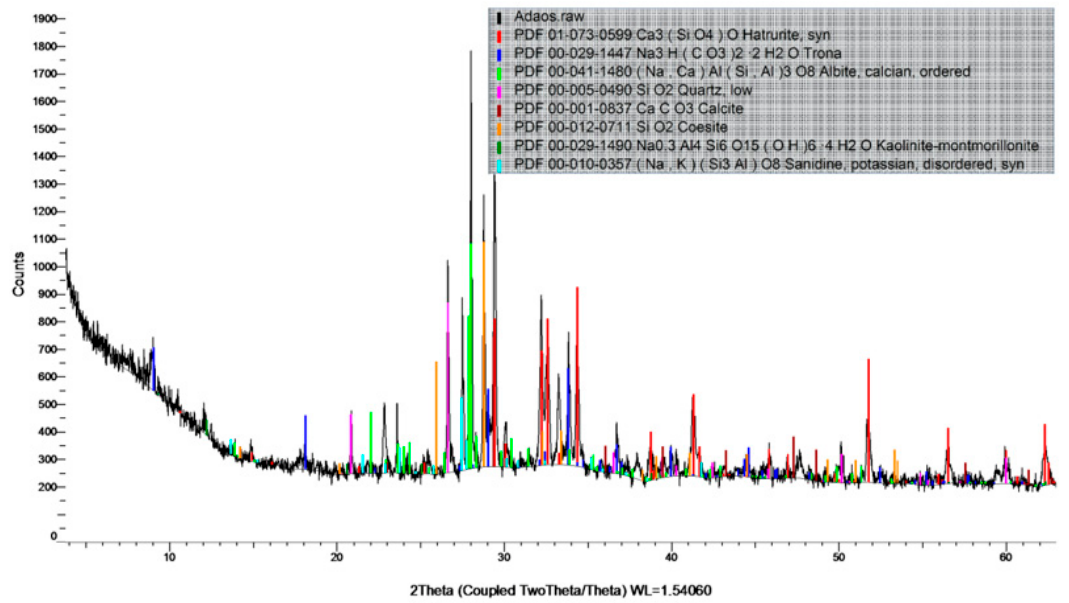
Figure 2. X-ray diffraction result of the ICW powder. The mix proportions are shown in Table 2 in relative mass proportions.